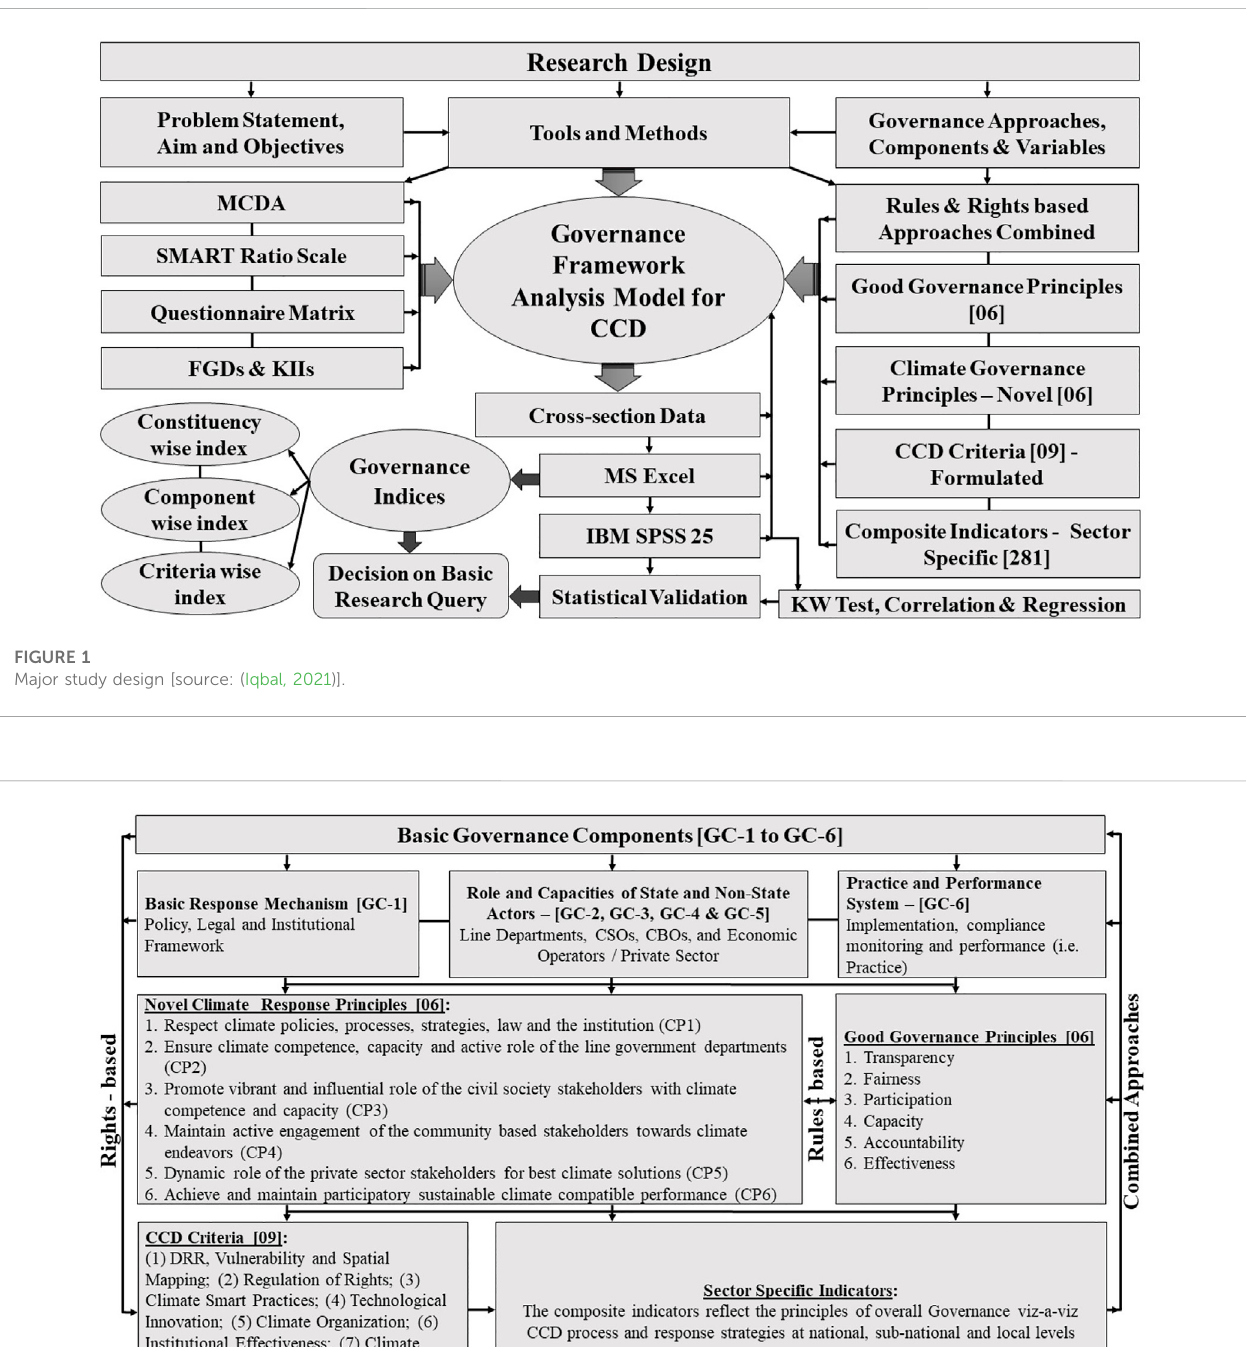
Frontiers in Environmental